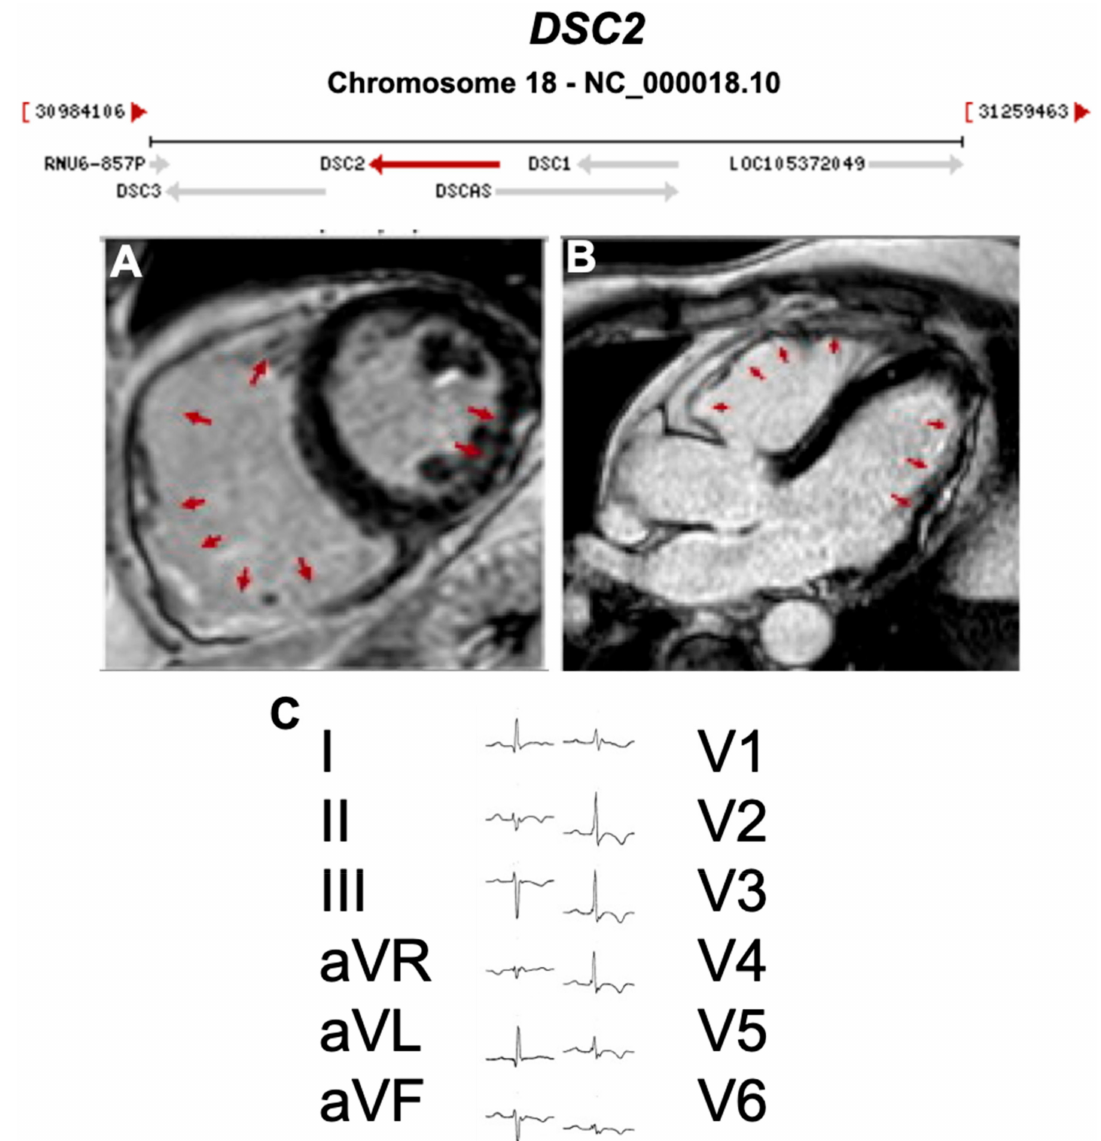
Figure 7. Exemplar MRI and ECG finding found in ACM patients with DSC2 mutations. ( A , B ) CMR of a patient with DSC2 p.Arg49His mutation showing biventricular involvement in the LGE mode (red arrows); ( C ) 12-lead ECG showing a reduction of R waves amplitude in left precordial leads (left involvement) and inverted T waves in V1-V6 (RV strain pattern); together they indicate biventricular involvement. Reproduced with permission from Gaido et al. (2017)